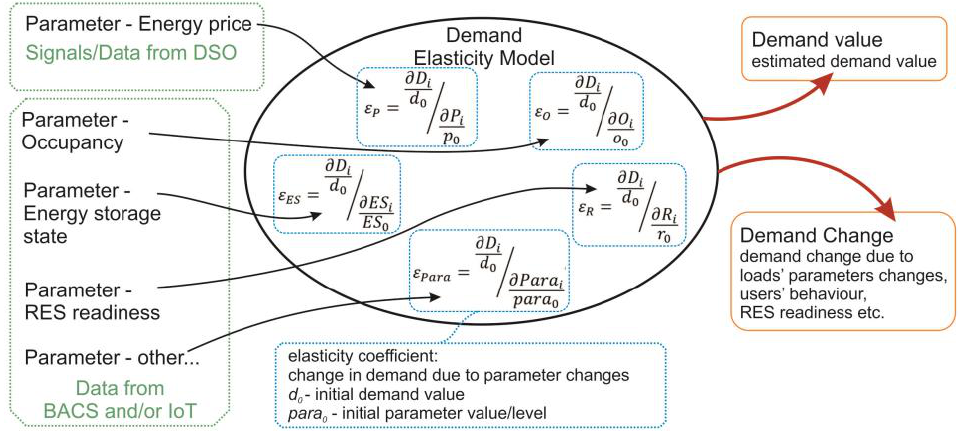
Figure 4. An extended demand elasticity model with selected factors pivotal for prosumer microgrids.